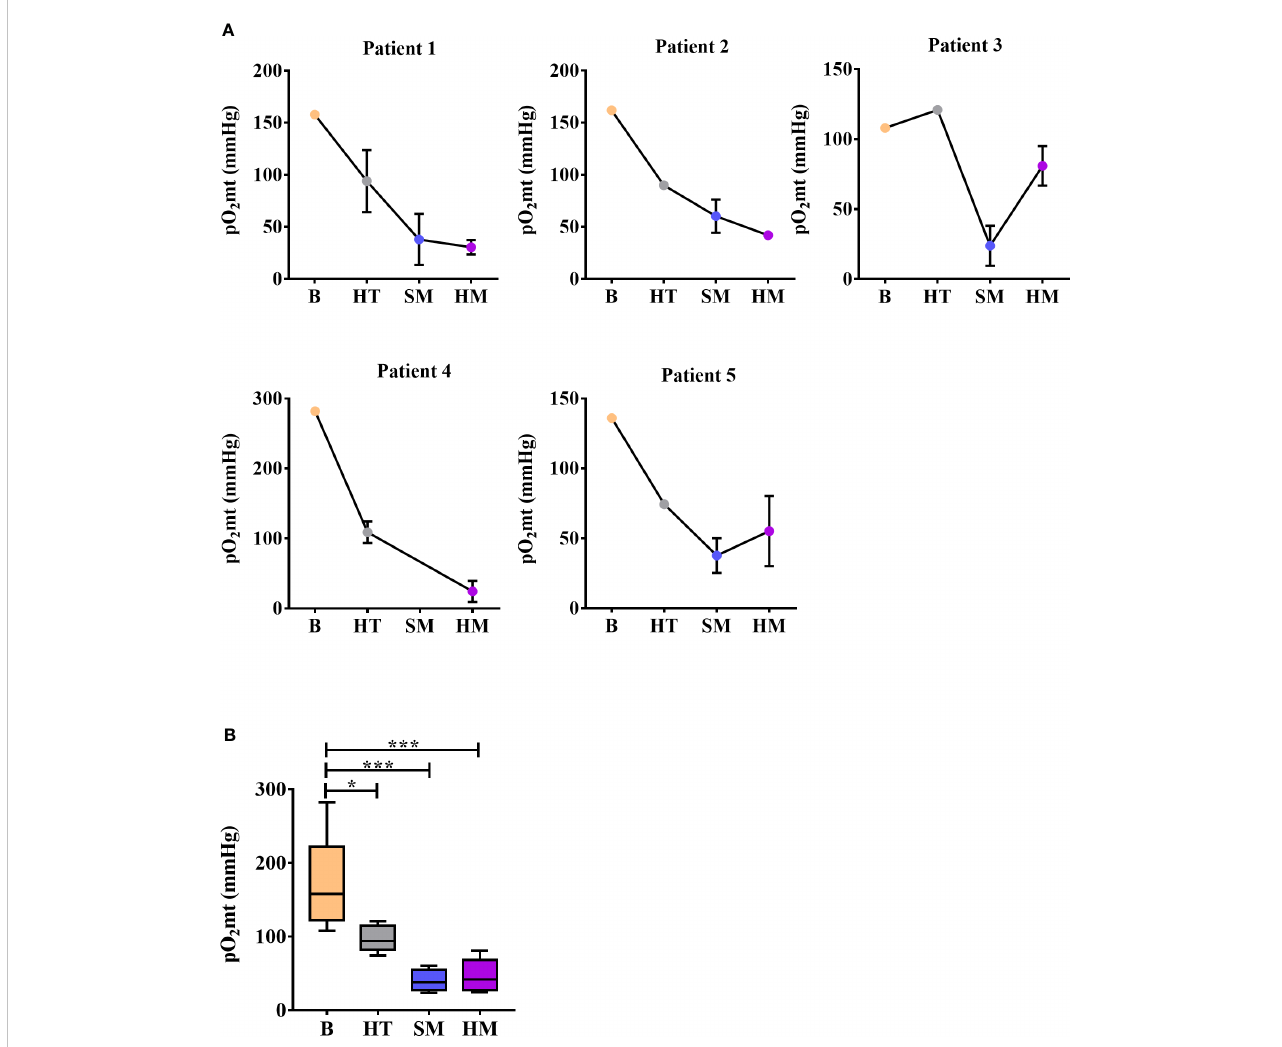
FIGURE 1 Measurement of intraoperative real-time oxygen microtension (pO 2 mt) in blood and tissues during surgery. (A) Individual measurements of pO 2 mt (mmHg) in blood (B), surrounding healthy tissue (HT), soft mucin (SM) and hard mucin (HM) in each PMP patient (n=5). Measurements are represented as the mean ± S.E.M of all values measured per zone in each patient. (B) pO 2 mt (mmHg) levels per zone taking into account all patients included in the study (n=5). One-way ANOVA analysis was carried out with multiple comparisons. * p < 0.05, *** p <